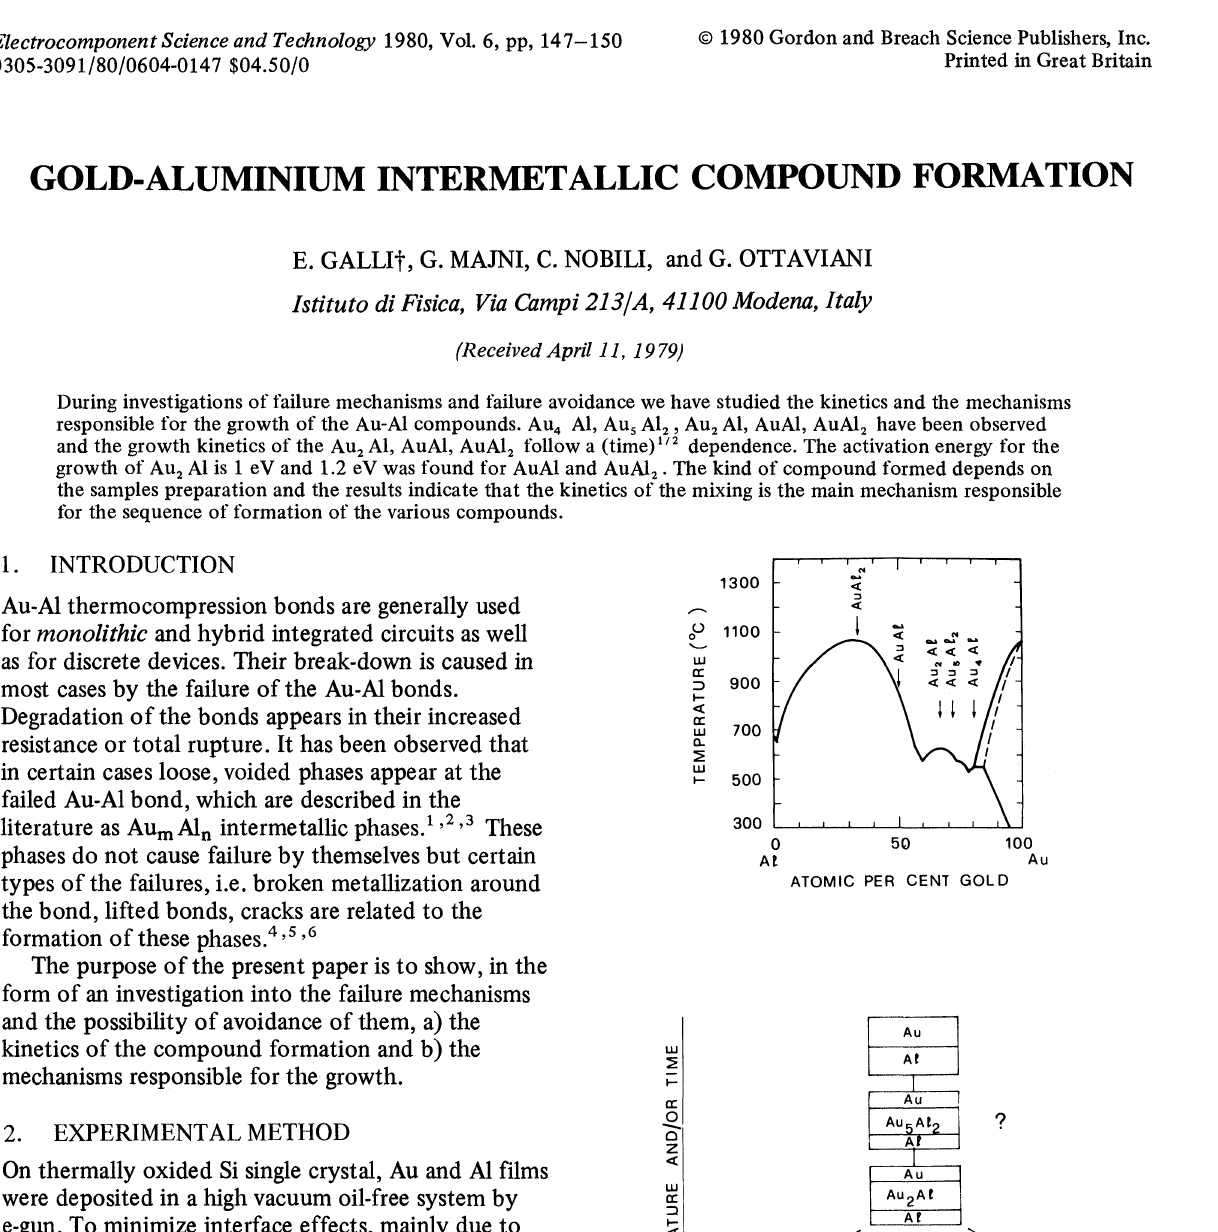
Schematic diagrams showing the compound formation in Au-A1 system. It seems that initially Au AI is formed by reaction at room temperature. Depending on the relative thickness of Au and A1 films, different compounds can be